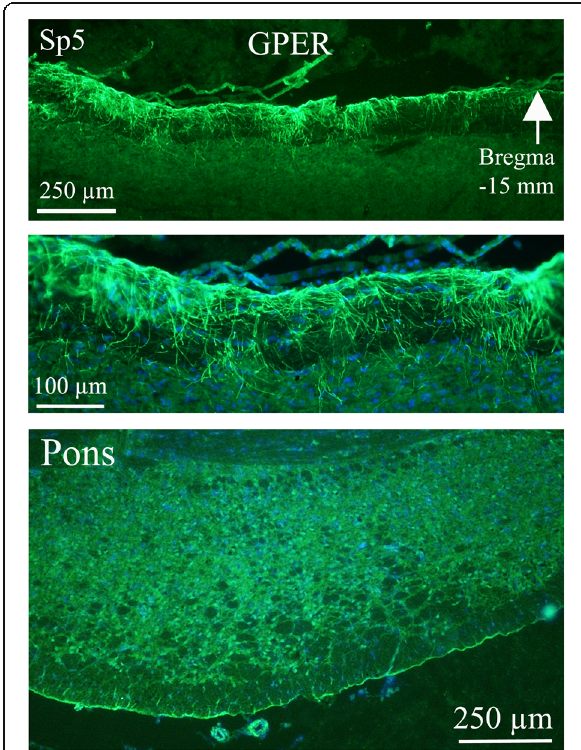
Fig. 4 GPER receptor distribution in the Sp5 and Pontine nuclei. GPER was mainly found in the Pontine nuclei , cerebellar molecular layer and the spinal trigeminal tract. The spinal trigeminal tract region (Sp5) constitutes an essential part of the pain pathways activated in migraine attacks. We found GPER immunoreactive fibers in the Sp5 region. In Pontine nuclei the GPER immunoreactivity was mainly found in the cell nuclei, but some cytoplasmatic and fiber staining were also found